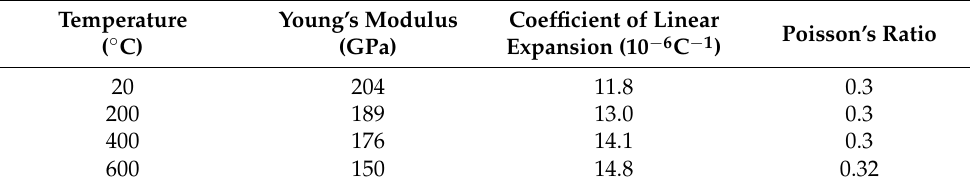
Table 2. Material properties of GH4169 at different